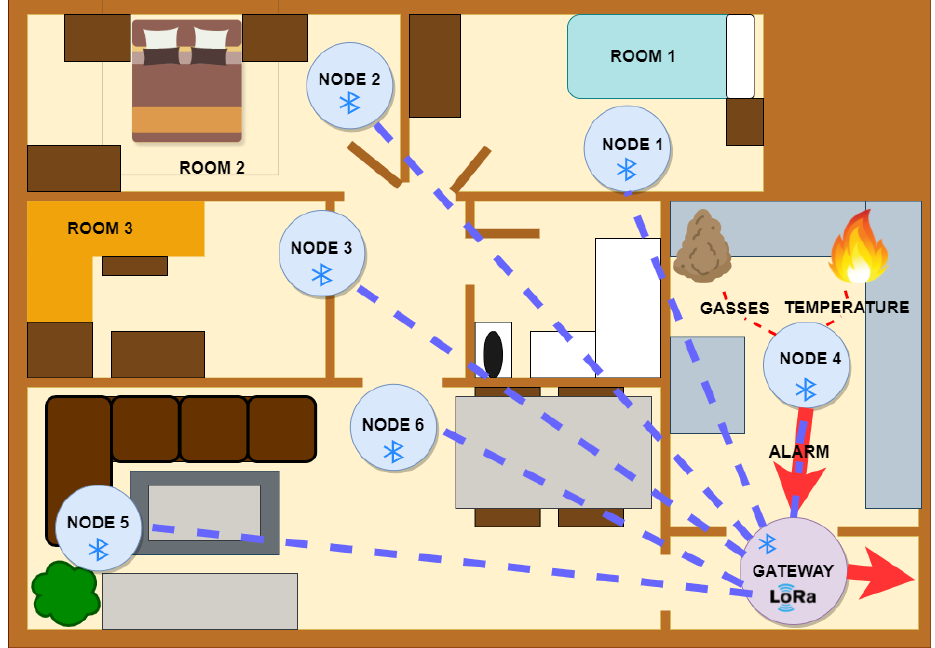
Figure 3. Layer 1: BLE network, star